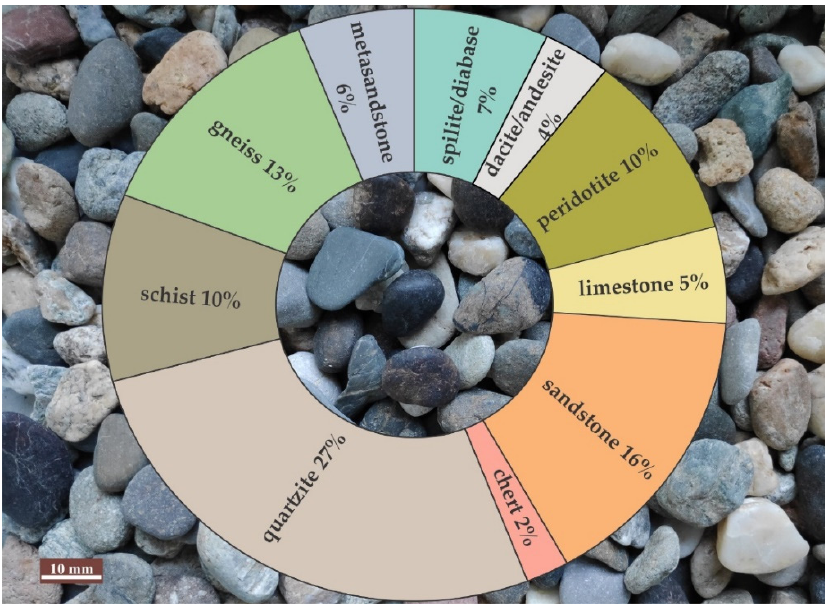
Figure 6. Chart of natural river aggregates (RA) shows different rock fragments in the 10/14 mm fraction. An image of the gravel used is in the background. The 10/14 mm fraction consisted mostly of fragments of metamorphic rocks (56%) and the same quantity of sedimentary (23%) and igneous rocks (21%). Within the fragments of metamorphic rocks, the most represented were quartzites, then fragments of gneisses and schists. Among sedimentary rocks, sandstones were the most common, but a small number of limestones and cherts were also found. Igneous rocks formed fragments of spilite-diabase, dacite-andesites, and peridotites (often serpentinized) (Figure 6). The gravel fragments mostly had spherical and elongated shapes and smooth surfaces. No mineral grains were found in the tested